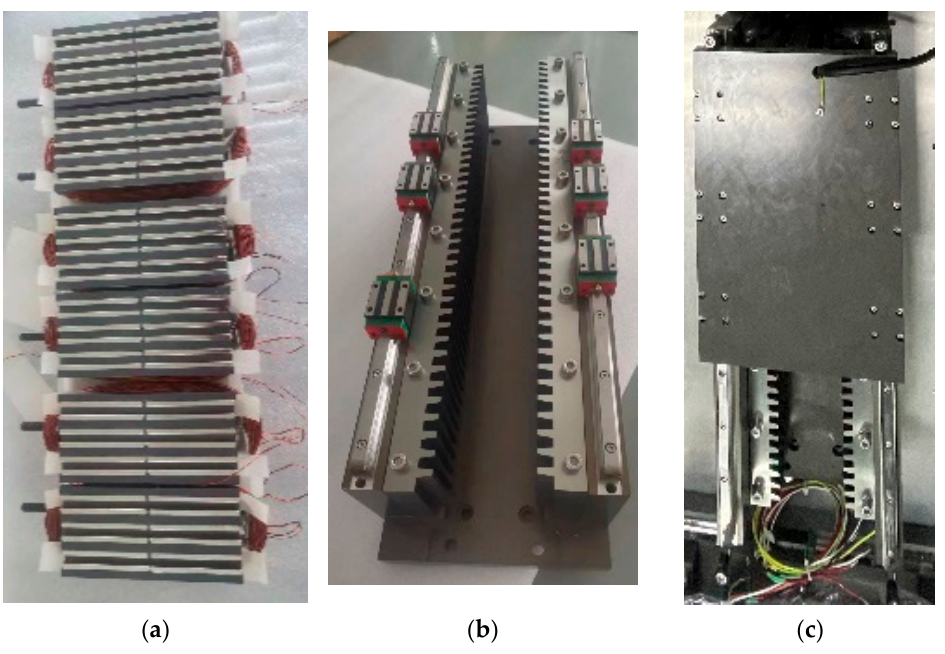
Figure 21. Prototype of STMLPMVG: ( a ) Mover. ( b ) Stator. ( c ) Machine structure. Figure 22 present the no-load back EMF waveforms of the STMLPMVG varying with time at a speed of 0.4 m/s. It can be seen from Figure 23 that the experimental result is in accord with the result of the FEM.